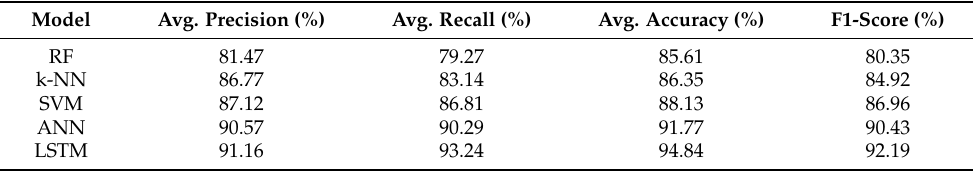
Figure 6. Training and validation curve for loss using 10-fold cross-validation: ( a ) ANN model, ( b ) LSTM model. Table 5. Performance assessment using 10-fold cross-validation on activity recognition with the healthy older people dataset